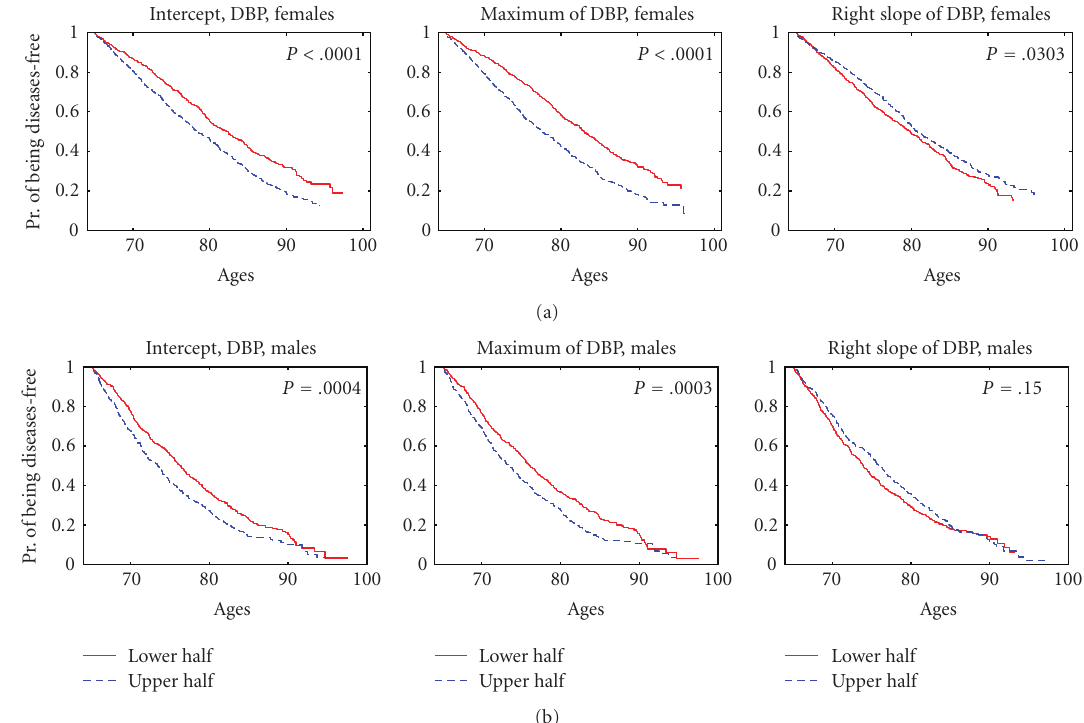
Figure 6: Kaplan-Meier estimates of probabilities of staying free of the diseases defining the onset of “unhealthy life” for females (a) and males (b) having initial values of diastolic blood pressure (DBP) at age 65, the estimated maximal values of DBP, and the average rates of decline of DBP after reaching the maximum (“intercept,” “maximum,” and “right slope,” respectively, see Section 2) from the lower and upper halves of empirical distributions of these risk factors; P denotes P value for the null hypotheses about the equality of the survival curves in the strata evaluated by the log-rank